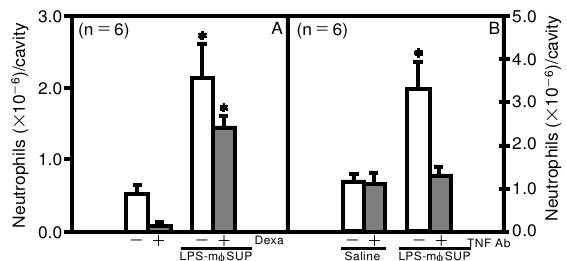
FIG. 2. Effects of dexamethasone pretreatment and preincu- bation of LPS-stimulated mouse macrophage supernatants with speci® c antibody to rmTNF a on capacity to induce neutrophil migration. ( A ) Bars represent neutrophil migra- tion induced by saline solution or LPS-stimulated mouse macrophage supernatants (LPS-M w SUP) into peritoneal cavities of mice, pretreated ( , hatched bars) or not ( , open bars) with dexamethasone (Dexa). ( B ) Bars represent neutrophil migration induced by LPS-M w SUP, incubated ( ) or not ( ) with 100 m g of IgG anti-rmTNF a , into peritoneal cavities of dexamethasone-pretreated mice. Con- trol groups received i.p. injections of saline solution or saline solution containing IgG anti-TNF a (100 m g/0.2 ml/ani- mal). In both panels, the results are reported as mean SEM for six animals in the group. P , 0 05 (Student’s t- test).